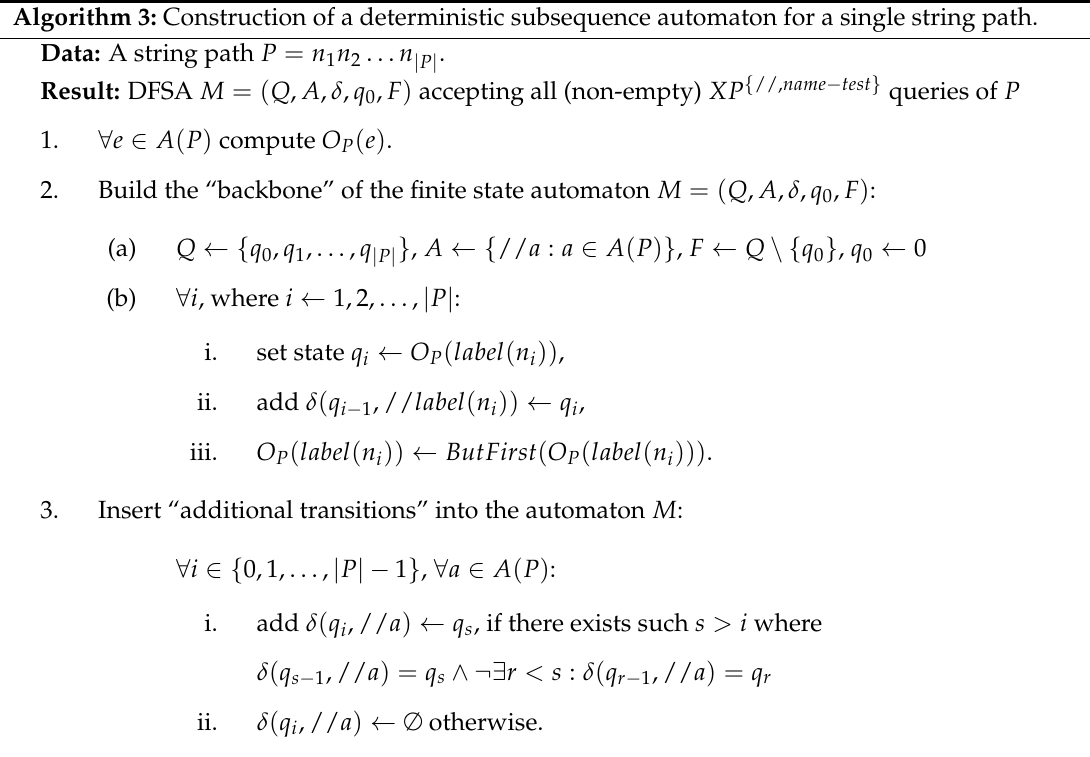
Algorithm 3: Construction of a deterministic subsequence automaton for a single string path. Data: A string path P = n 1 n 2 . . . n | P |